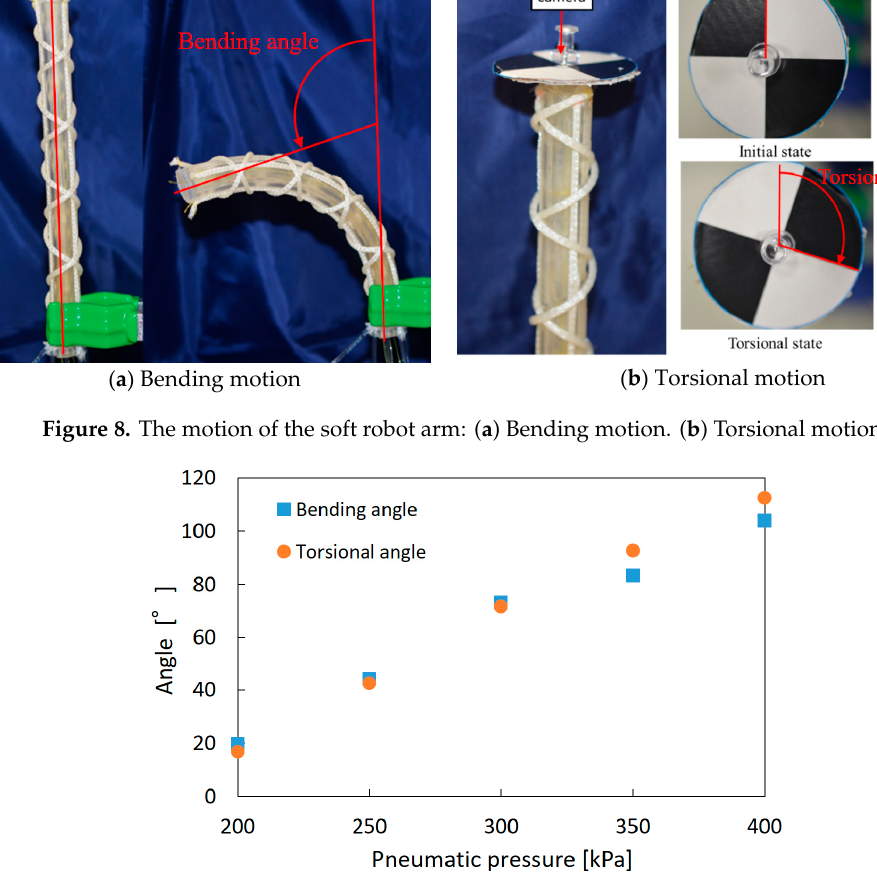
Figure 9. Fundamental motion characteristics of the soft robot arm.